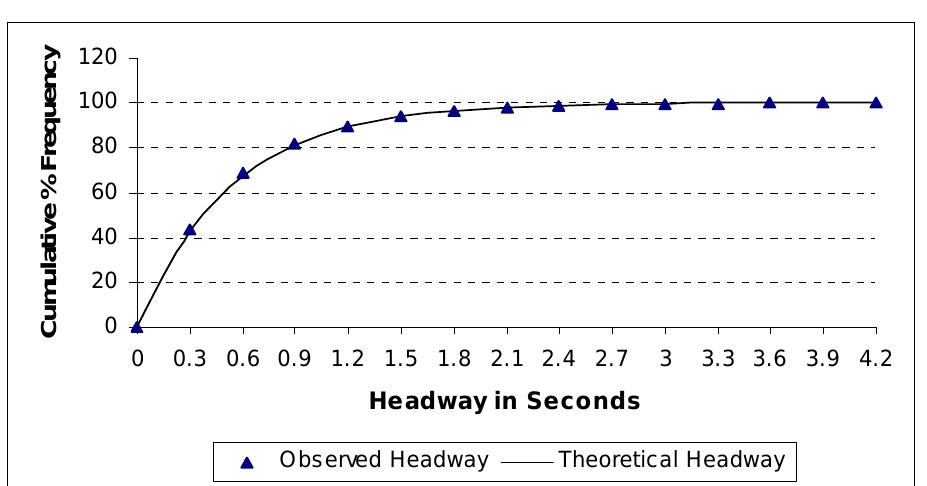
Figure 5. Goodness of fit of observed and theoretical